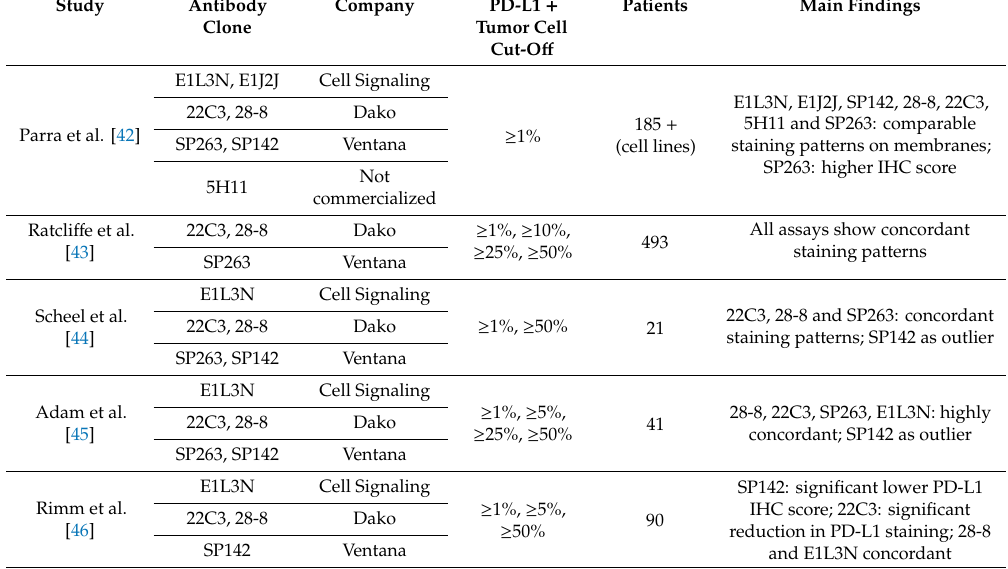
Harmonization studies on immunohistochemistry (IHC) PD-L1 staining of NSCLC tissue